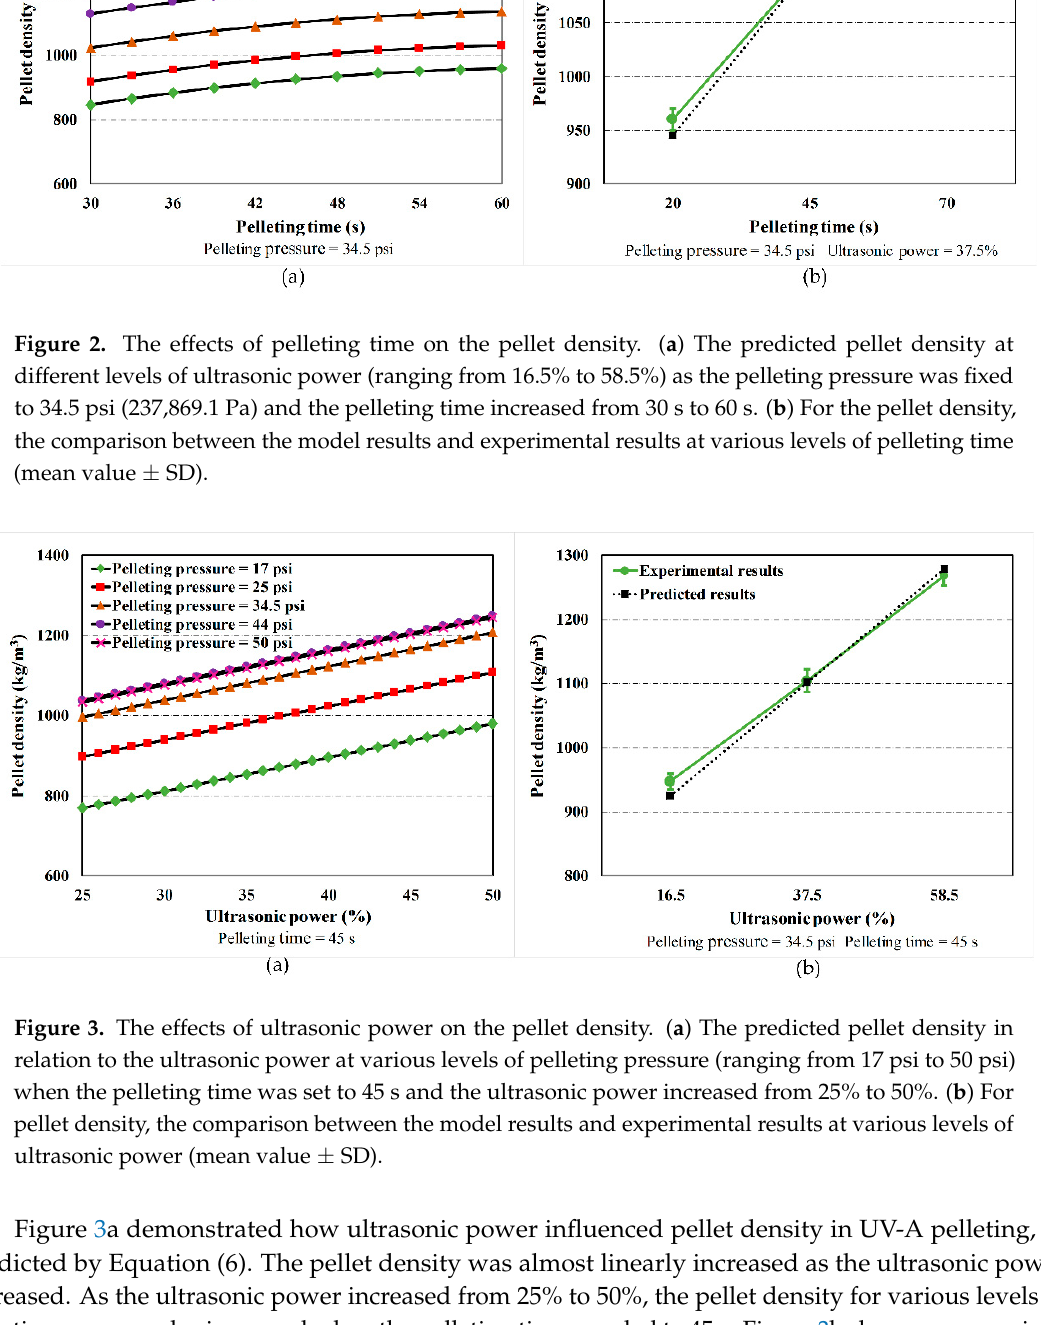
Figure 2. The effects of pelleting time on the pellet density. ( a ) The predicted pellet density at different levels of ultrasonic power (ranging from 16.5% to 58.5%) as the pelleting pressure was fixed to 34.5 psi (237,869.1 Pa) and the pelleting time increased from 30 s to 60 s. ( b ) For the pellet density, the comparison between the model results and experimental results at various levels of pelleting time (mean value ± SD).